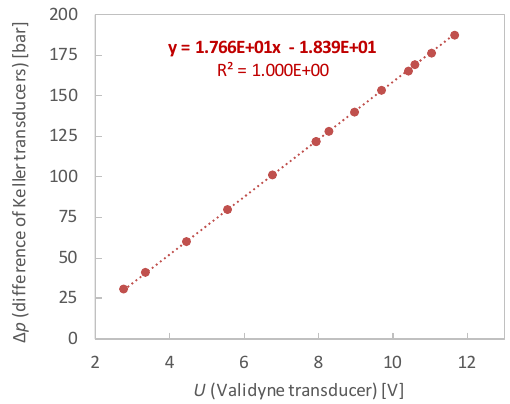
Fig. 3. Calibration curve for differential pressure transducer (DPT) measuring pressure drop over isothermal capillary tubes within liquid